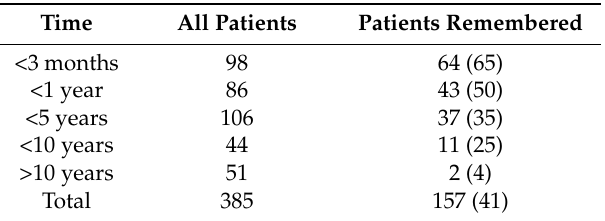
Table 1. Length of time since last contact with the clinic before death, total sample and patients remembered by staff (%).